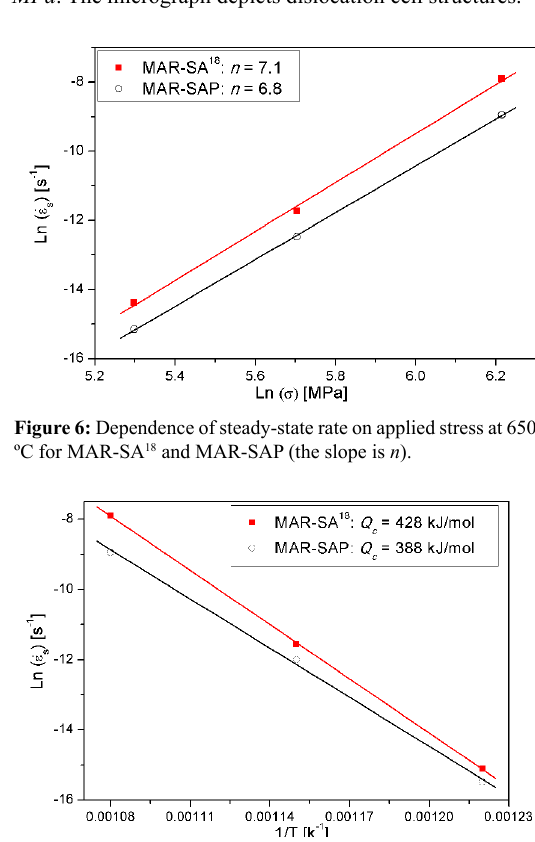
Figure 7: Dependence of steady-state rate on temperature at 500 MPa for MAR-SA 18 and MAR-SAP (the slope is – Q